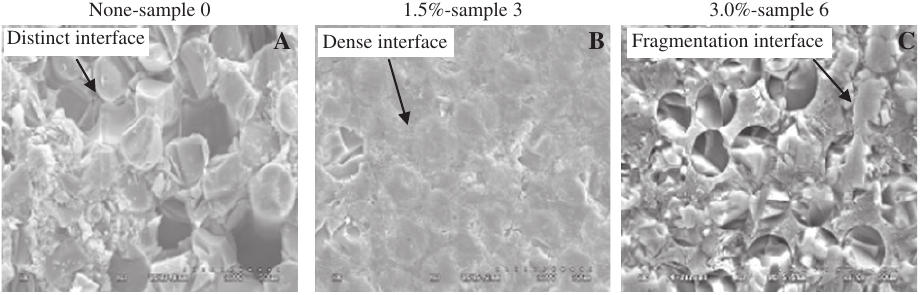
Figure 3 Comparative SEM micrograph of the GFRP-anchor body with different nano mullite powder contents.